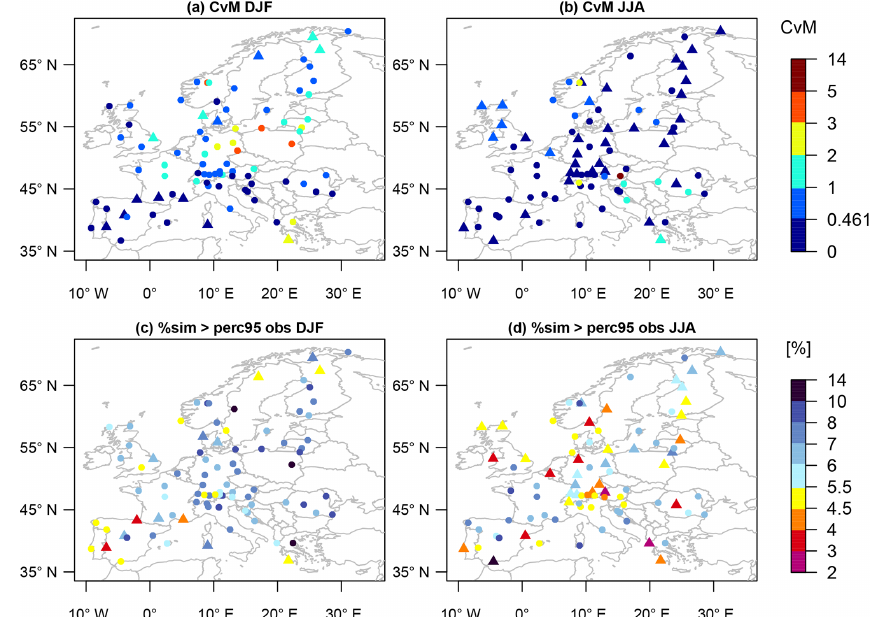
Figure 4. Step 1: bias correction to grid scale. (a, b) CvM score for the selected cross-validated predictor against E-OBS. Threshold for values under which the model cdf is not statistically significantly different at the 95% level from the reference cdf: 0.461. (c, d) Percentage of wet days in the CvM-selected cross-validated predictor exceeding the 95th percentile of wet days in E-OBS (%sim > perc95 obs ). Selected model: circles: QM grid -corrected RCM; triangles: uncorrected